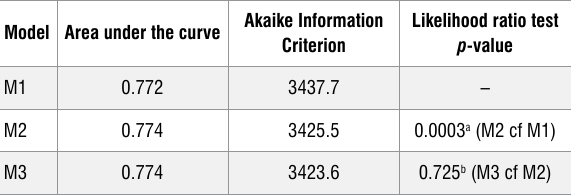
Comparison of models for predicting risk of silicosis Akaike Information Likelihood ratio test Model Area under the curve Criterion p -value